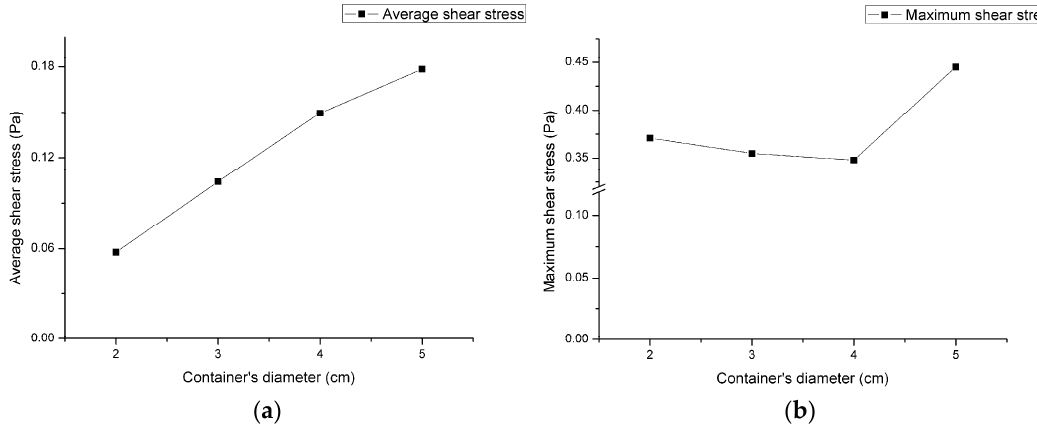
Figure 7. The variation of ( a ) the average shear stress, and ( b ) the maximum shear stress along the specific diameter as defined in Figure 3 on the bottom surface of the container with four containers’ diameters. (Rotating diameter = 1 cm and rotating speed = 120 rpm)